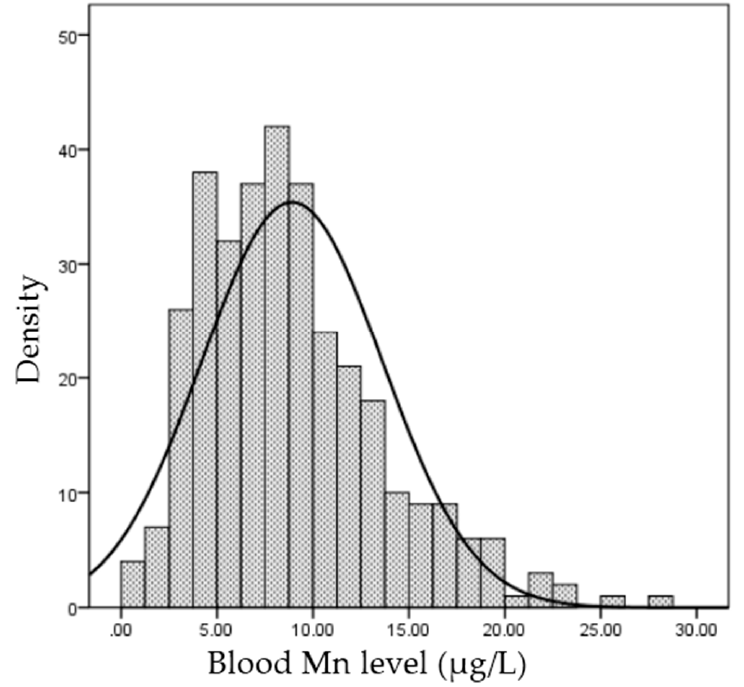
Figure 1. Distribution of blood Manganese (Mn).